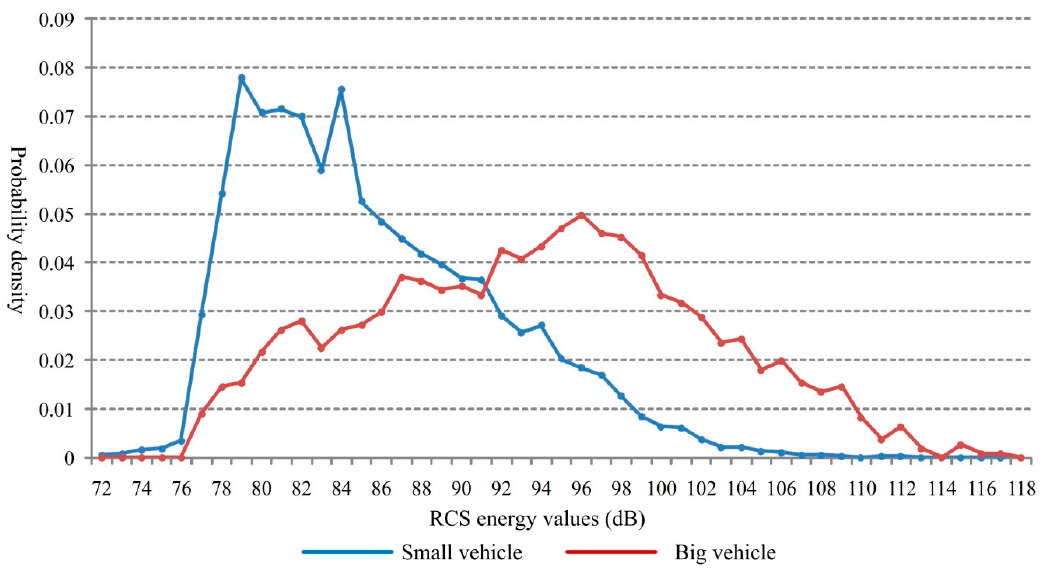
Figure 11. Probability distributions for the two types of vehicles.